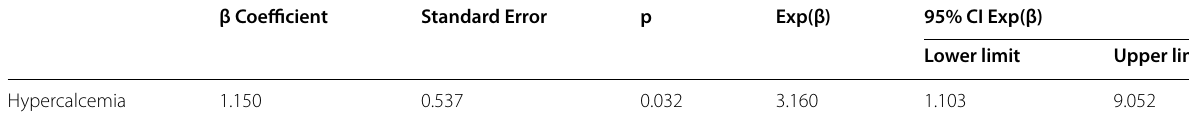
CI, confidence interval